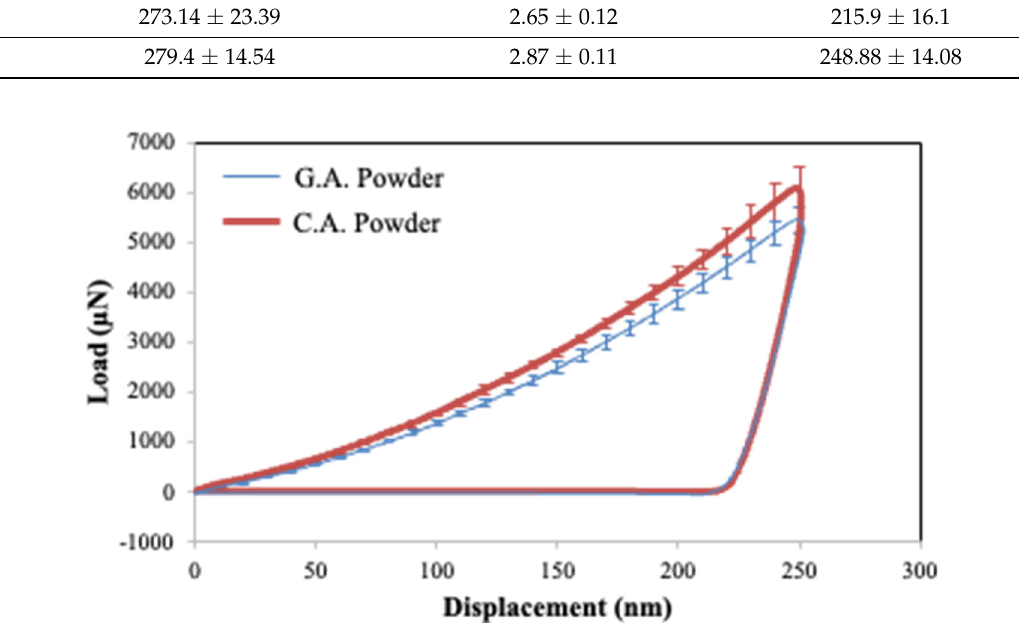
Figure 10. Load ‐ displacement response of nanoindentation test on C.A and G.A powders.